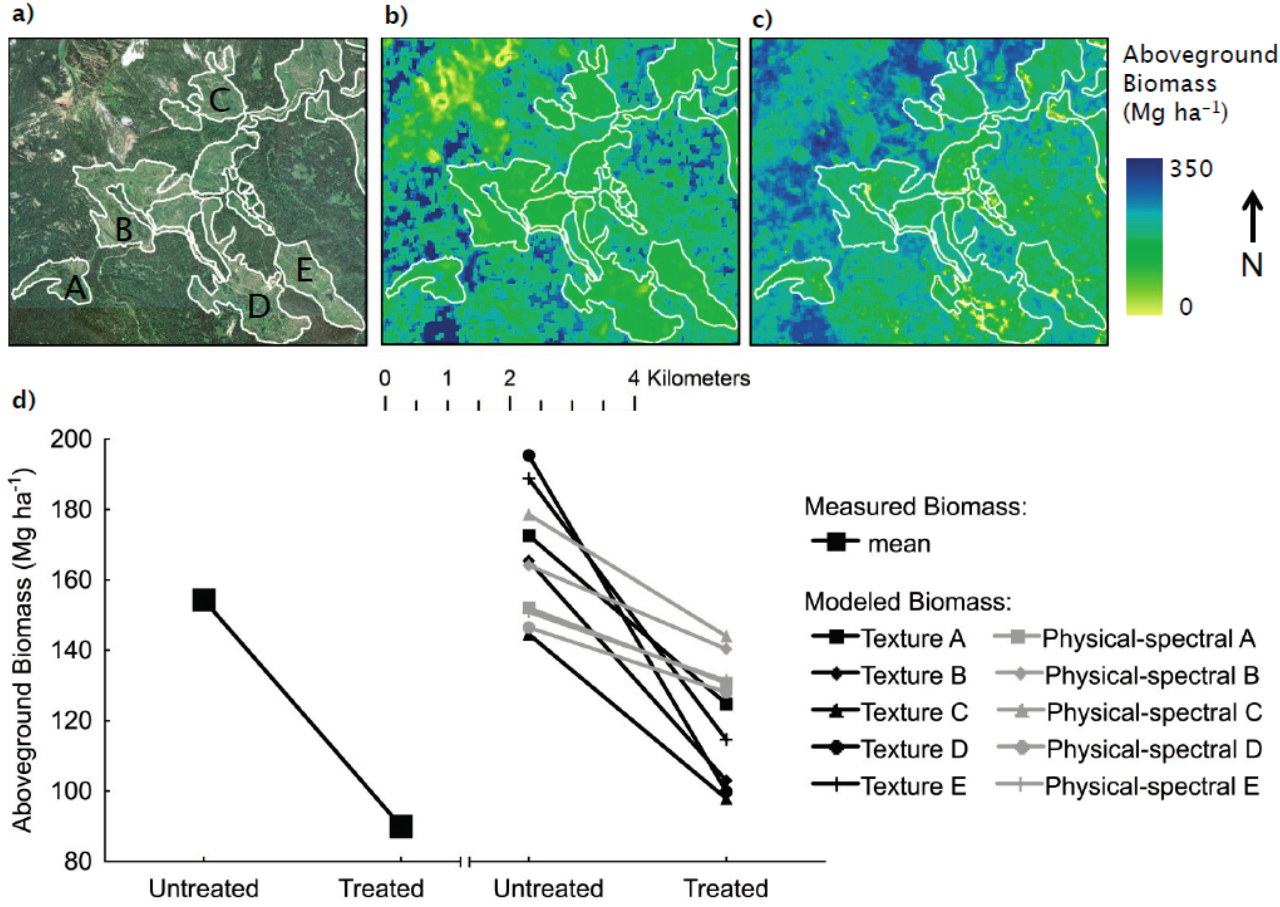
Figure 4. ( a ) True color image from National Agricultural Imagery Program acquired by a Leica ADS80 Airborne Digital Sensor; ( b ) image texture-based biomass map; and ( c ) physical-spectral (slope, aspect, elevation, Normalized Difference Vegetation Index) based biomass map for a region of San Juan National Forest containing forested stands clear-cut in the 1970s. Color bar and scale bar apply to (a), (b), and (c); ( d ) Observed and modeled stand-average aboveground biomass from adjacent untreated and treated (clear-cut) forest stands. Observed values are calculated from nearby stands of the same vegetation type. Modeled stand-average biomass of treated stands was compared to the stand-average biomass of the untreated stand located directly to the west. Letters indicate locations of biomass comparisons, shown on